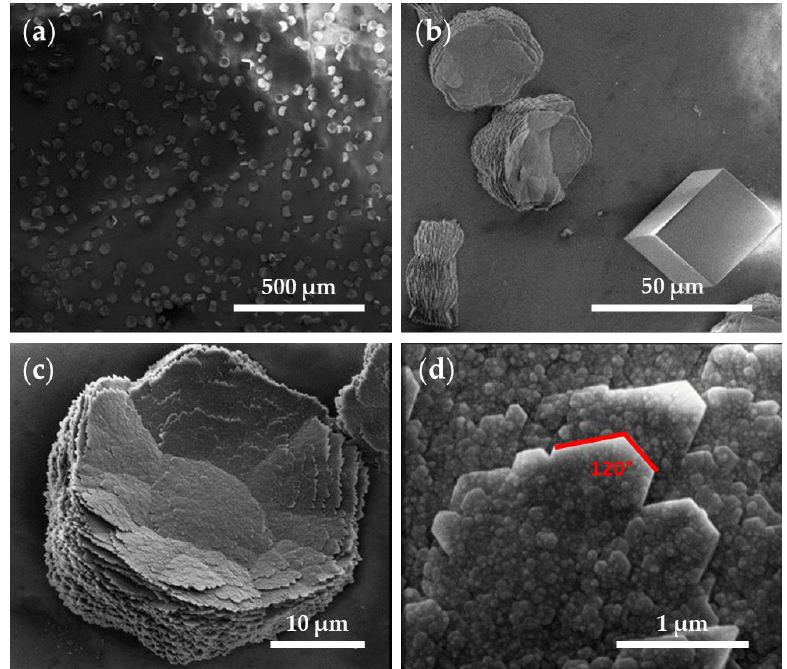
Figure 6. Average fiber diameter of the ( a ) R‑P/G‑EPnF meshes obtained with the flat collector and ( b ) A‑P/G‑EPnF meshes obtained with the rotary collector. Asterisk (*) indicates p < 0.05.